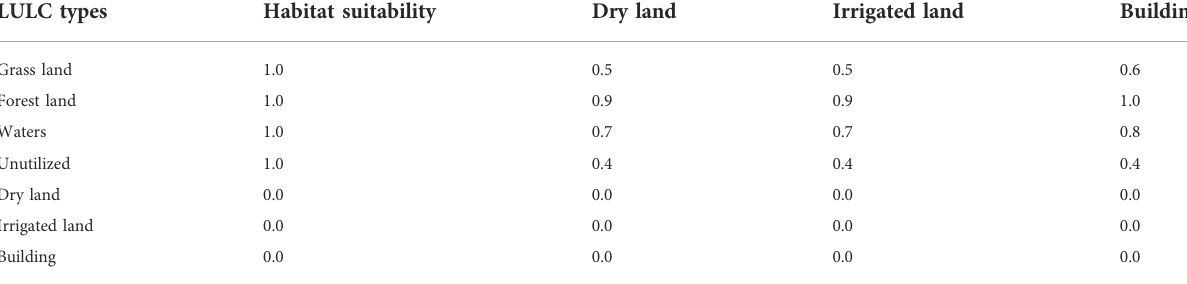
TABLE 3 Habitat suitability of land use types and their sensitivity to various threat